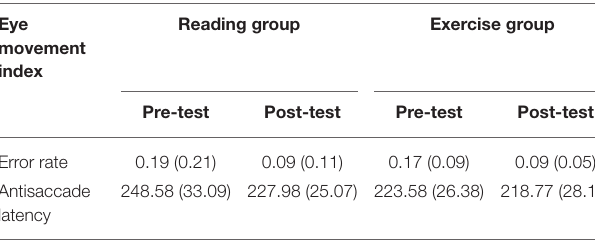
TABLE 1 | Mean (SD) of eye movement measures in pre- and post-test antisaccade task for two